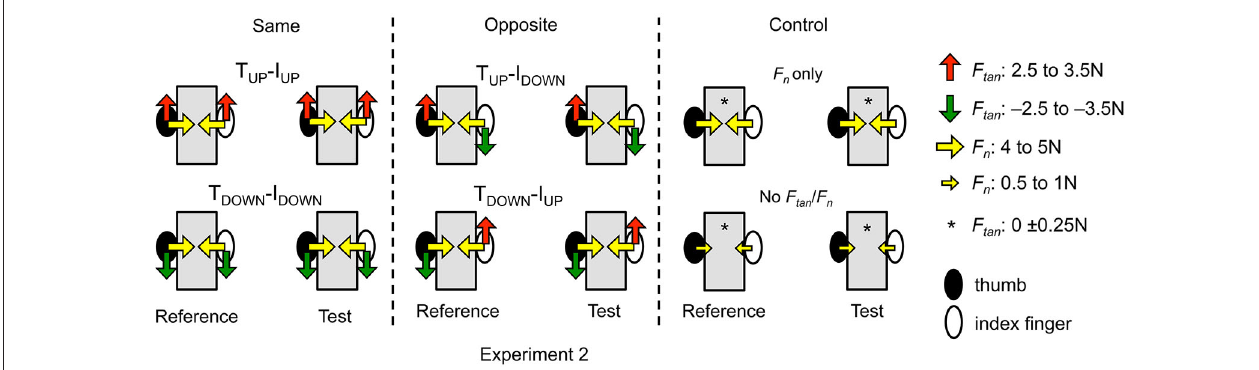
is that for the latter experiment, subjects were required to exert the same thumb and index fingertip normal and tangential forces across reference and test hands (see text for more